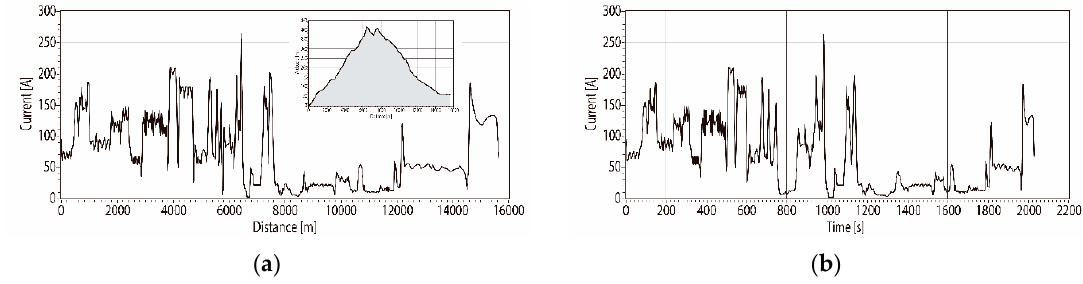
Figure 23. ( a ) Motor current on the travel road and road topography, ( b ) Motor current on time.